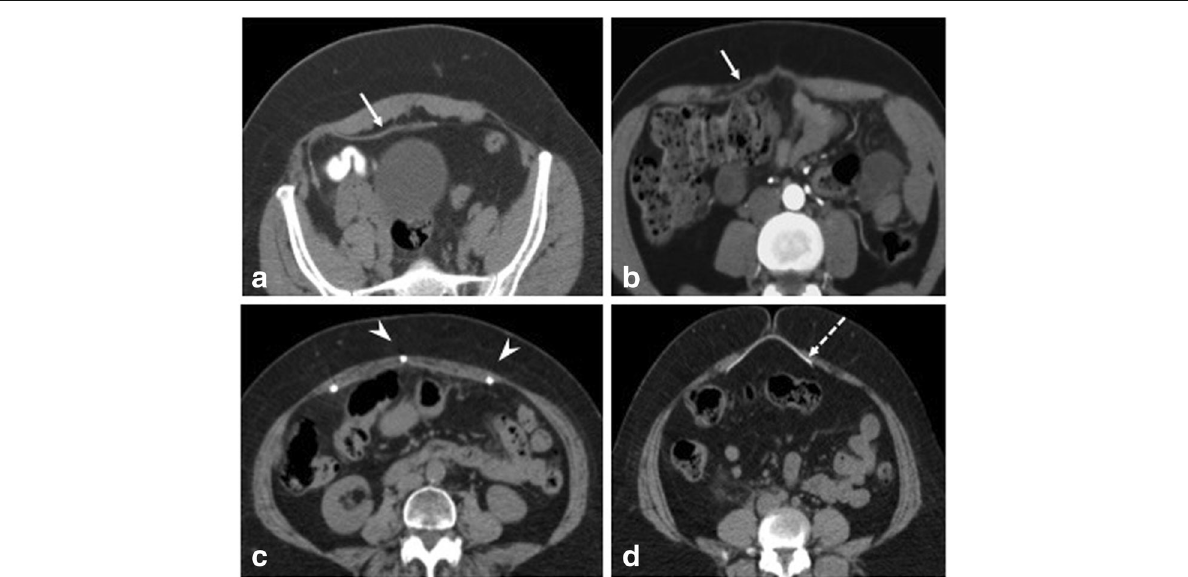
Fig. 3 Mesh appearances on CT axial sections. a Preperitoneal placement of Prolene-based mesh appearing isodense to muscle. Presence of fat can aid in better visualization of the mesh. b Inlay Prolene-based mesh placement (arrow). c Laparoscopic intraperitoneal placement of mesh with tackers (arrowheads). d Mesh made of PTFE appearing radiodense (dashed arrow)